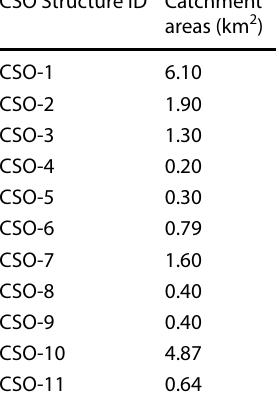
Table 1 Catchment areas of different CSO structures of Hatirjheel